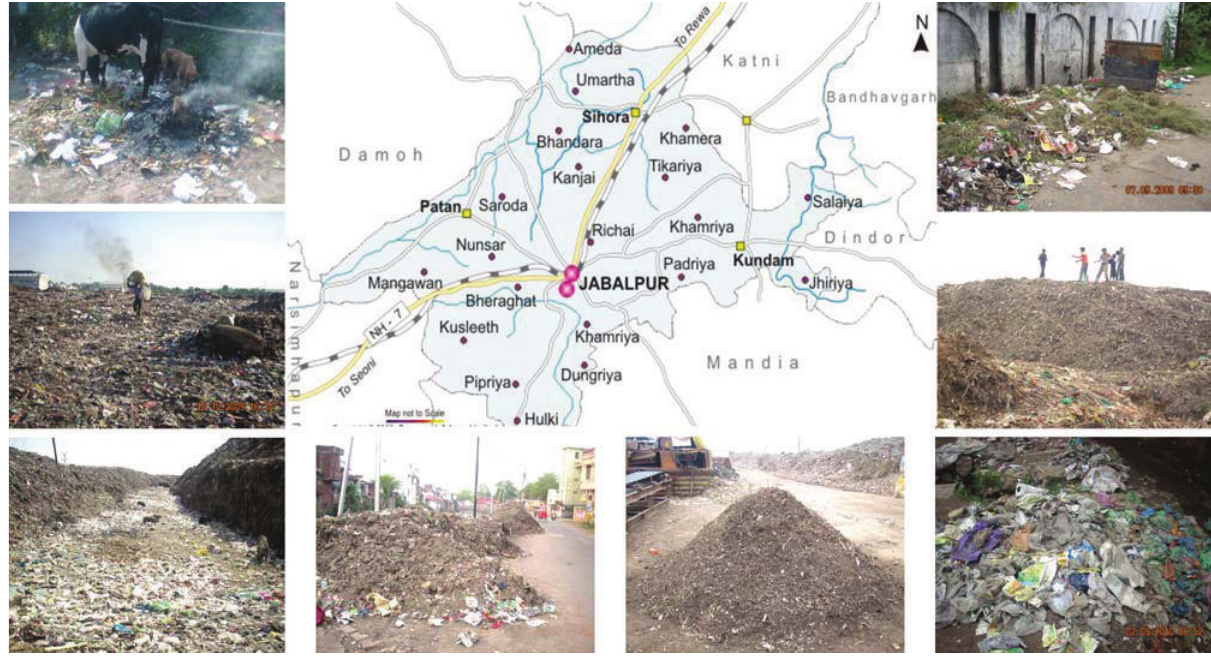
Figure 1: Collection of samples from di ff erent waste dump sites of